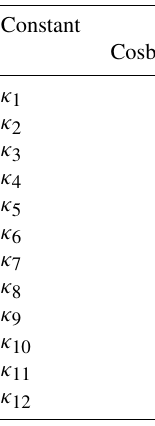
Table 2. Values of the constants commonly used in the Cosby pe- dotransfer